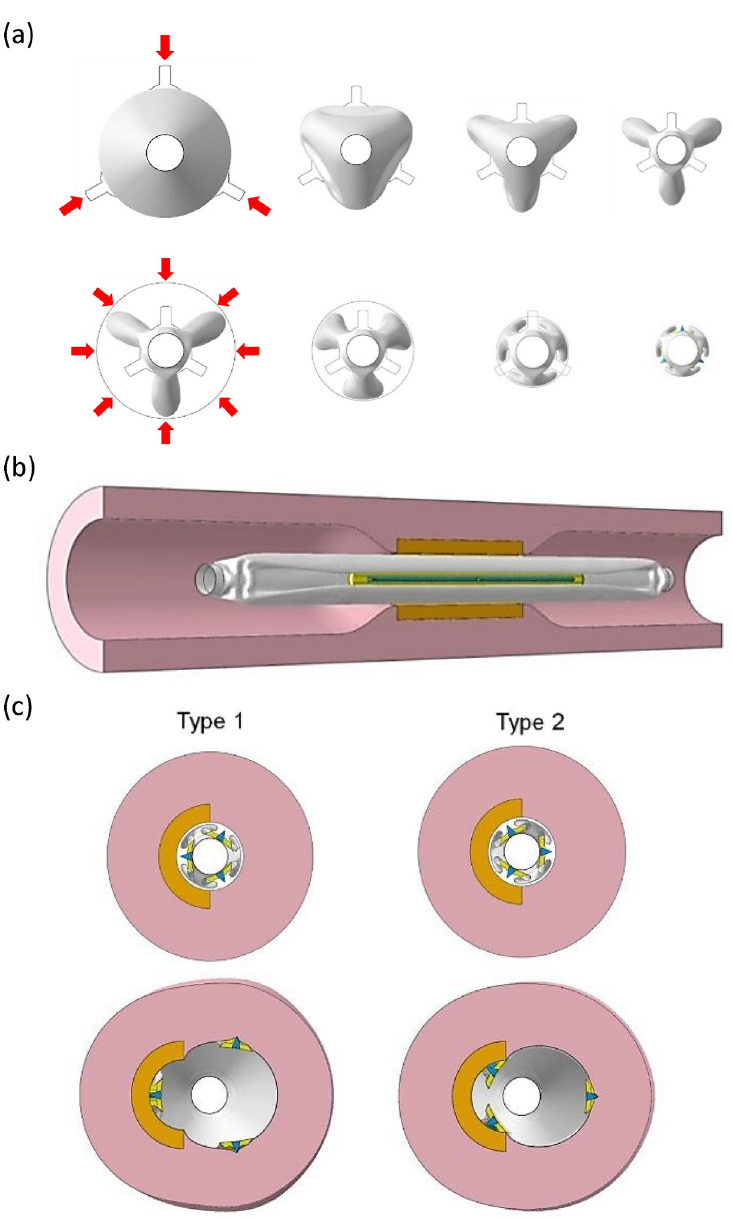
Fig 2. Expansion of cutting balloon in the stenotic calcified artery models. (a) Crimp and compression process of a folded balloon. (b) Configuration of cutting balloon in the calcified artery model. (c) Two types of models for the analysis (Type 1: one blade is placed inside the calcification model, Type 2: two blades are placed inside the calcification model).